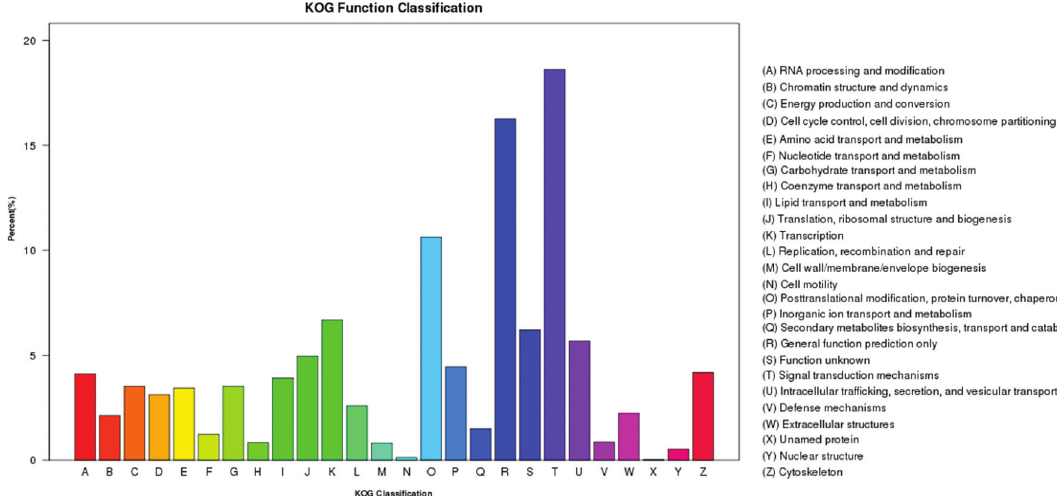
Figure 3 - KOG classifications of unigenes from the P